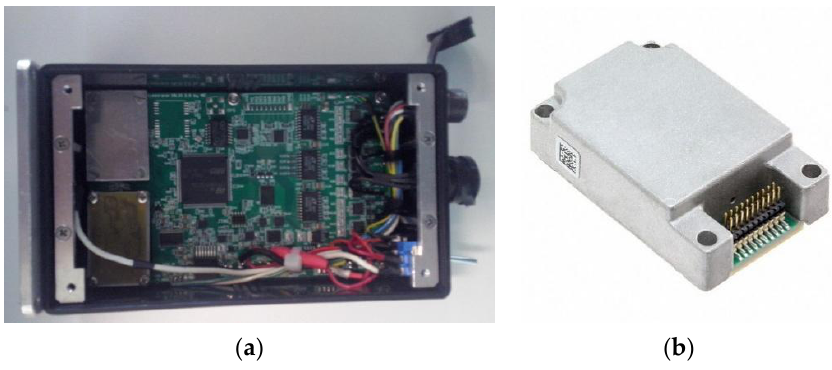
Figure 7. ( a ) Onboard computer; ( b ) ADIS16448 sensor.